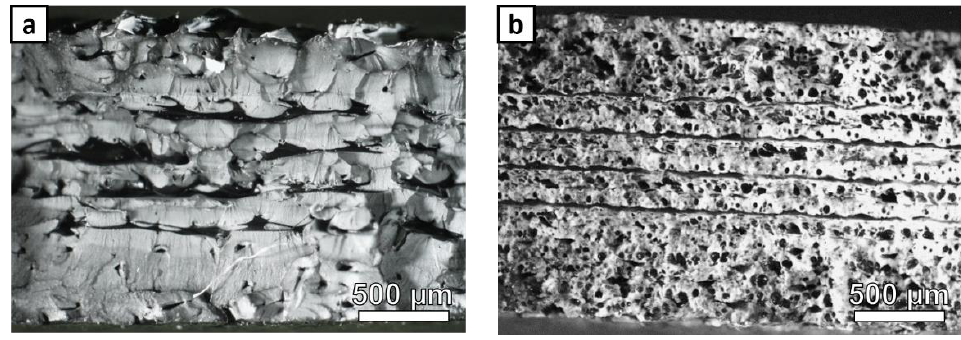
Figure 20. Fracture surfaces of tensile tested specimens with a 0.2 mm layer height: ( a ) Pure ABS and ( b ) ABS w/5%CF.